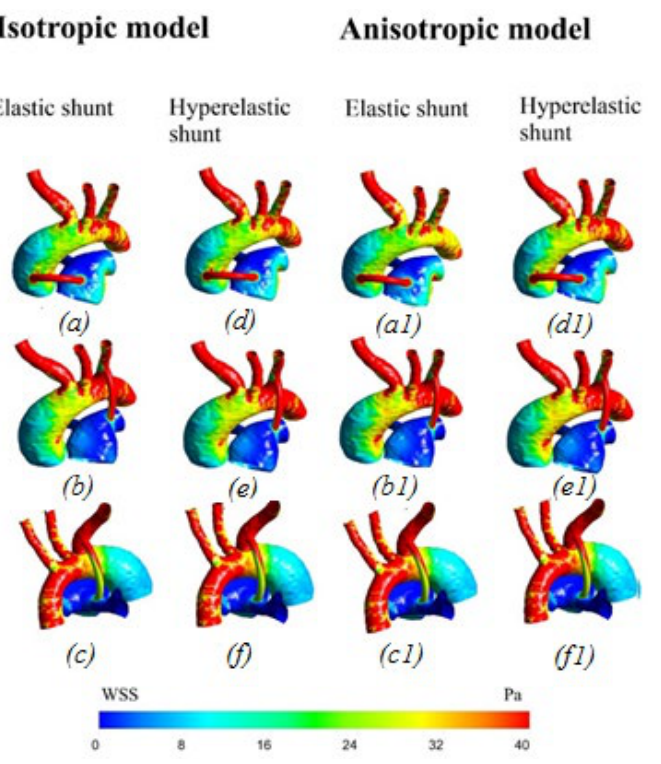
Figure 13. Wall shear stress distribution: ( a , d , a1 , d1 ) central shunt; ( b , e , b1 , e1 ) right shunt; ( c , f , c1 , f1 ) left shunt.